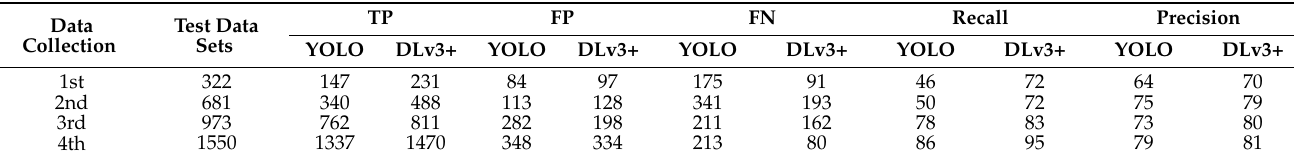
Table 8. Cultivated land search results for